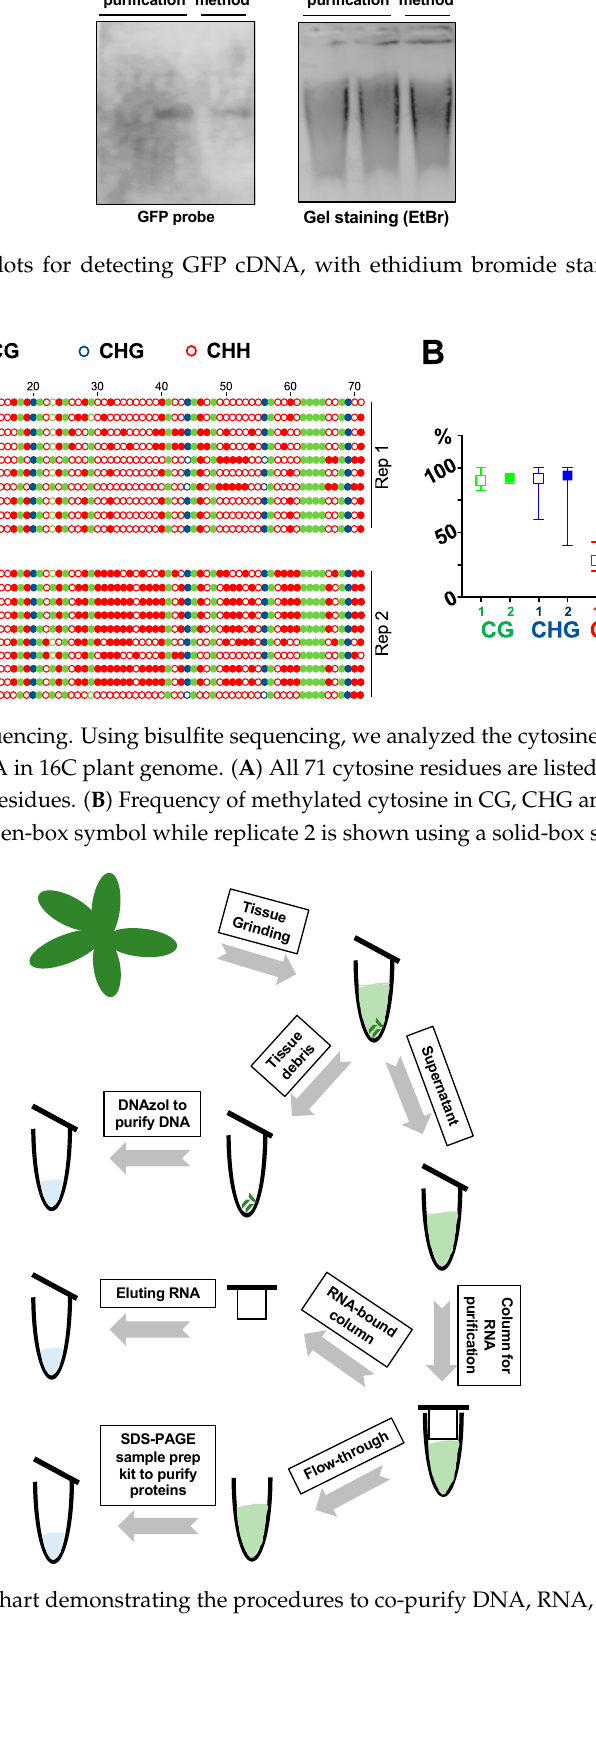
Figure 4. A flow chart demonstrating the procedures to co-purify DNA, RNA, and proteins. 3.3. Co-Purification of DNA/RNA/Protein from Protoplasts We are interested in testing whether this method is efficient for small quantity samples, such as protoplasts. Here, we used RZ-Int PSTVd RNA as the inoculum, together with GFP reporter plasmids (35S::GFP), to co-transfect A. thaliana protoplasts. PSTVd replicates in A. thaliana [20,23] but cannot achieve systemic trafficking [20]. In our test, about 2 × 10 5 protoplast cells were harvested two days post-transfection and were subjected to nucleic acids and protein purification using our method. As